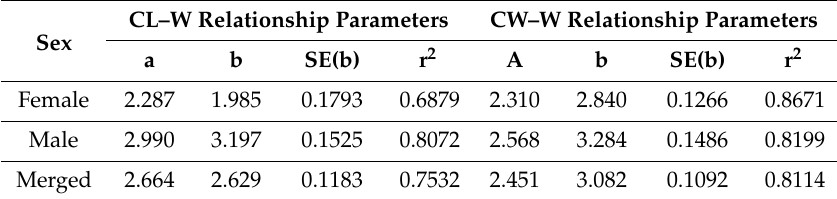
Table 3. CL–W and CW–W relationships’ parameters during the sampling period.